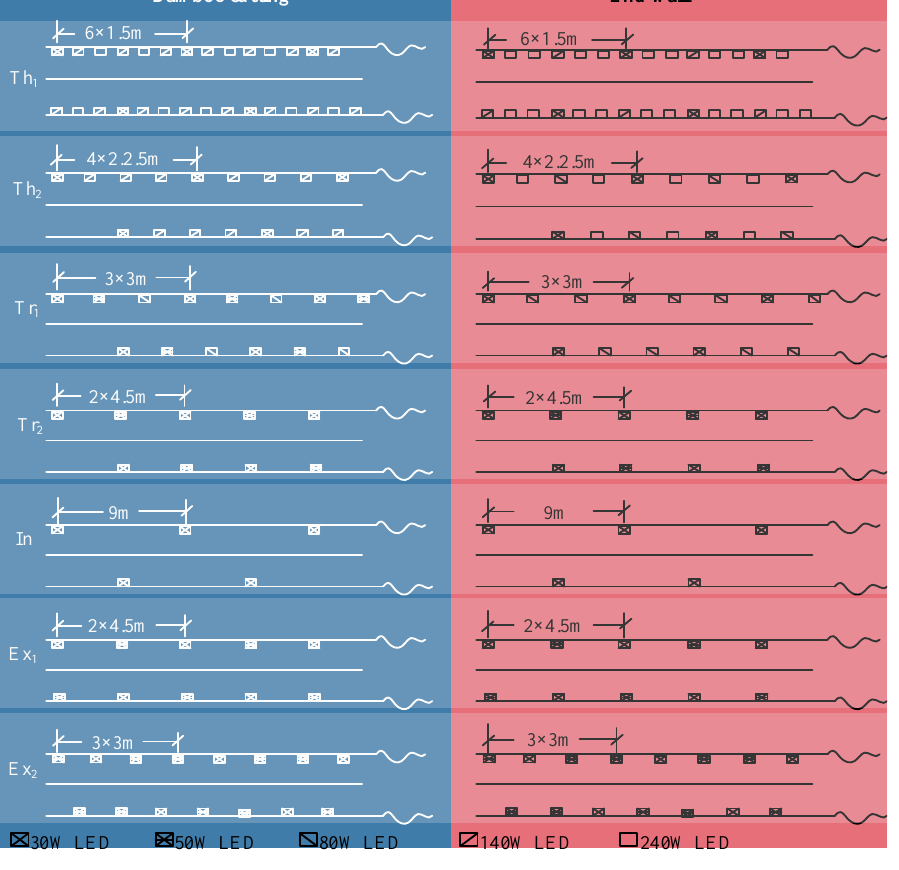
Figure 7. Lamps ’ installation rules for study tunnels. Figure 7. Lamps’ installation rules for study tunnels. Table 6. Details of initial installation costs for road tunnel lighting systems. Table 6. Details of initial installation costs for road tunnel lighting